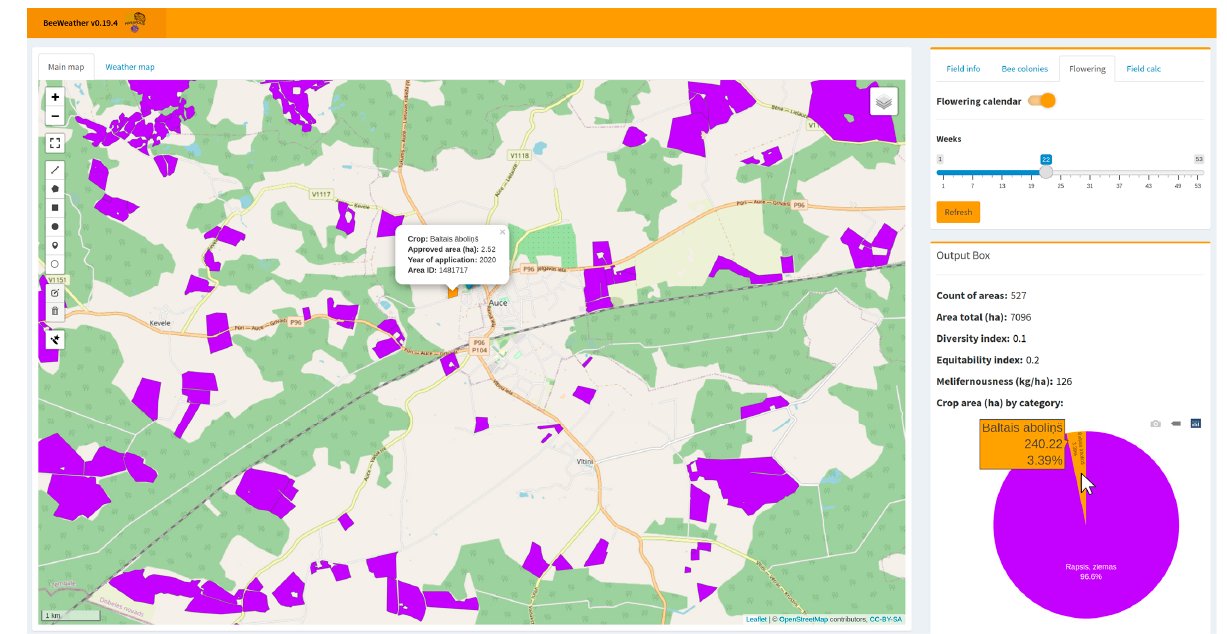
Agriculture 2023 , 13 , x FOR PEER REVIEW Figure 5. Flowering simulation for week 22. Figure 5. Flowering simulation for week 22.